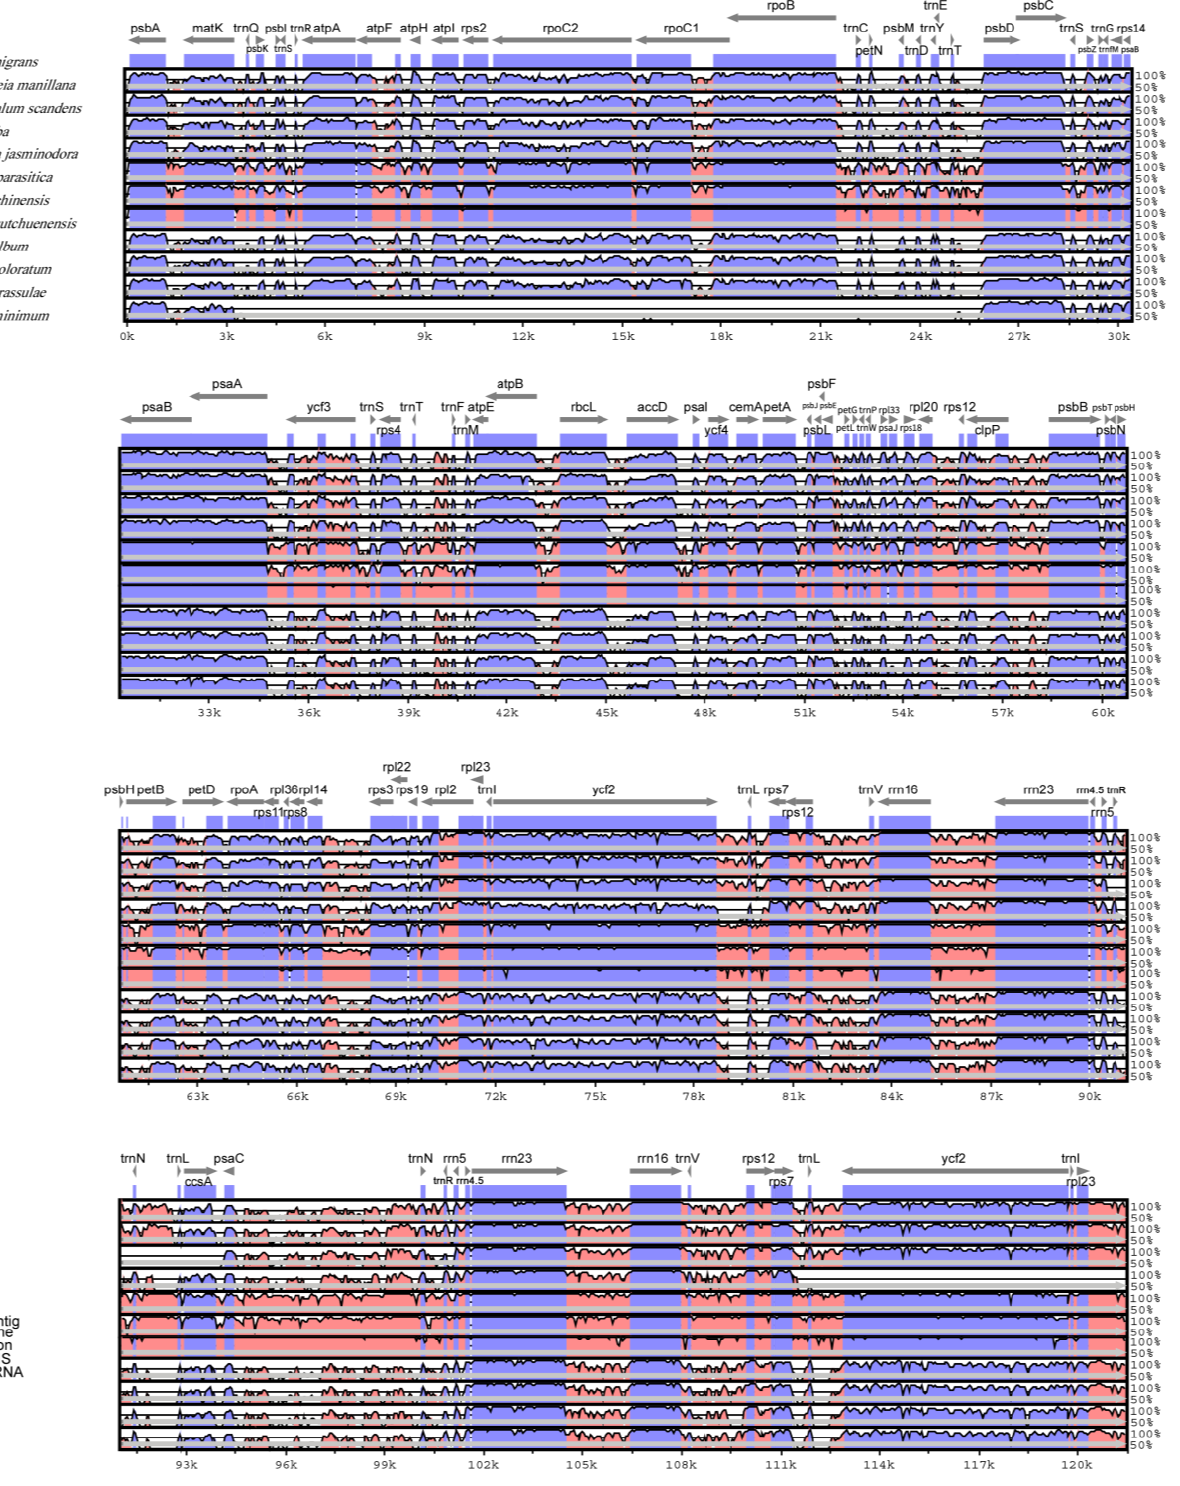
Figure 2. Comparison of the chloroplast genomes of the 12 species, using T. nigrans as a reference in the mVISTA program. (Grey arrows and thick black lines above the alignment indicate the orientation of genes. A cut-off of 70% identity was used for the plots. The Y-scale axis represents the percent identity within 50%–100%. Genomic regions are color-coded as either protein-coding exons, rRNAs, tRNAs, or conserved non-coding sequences (CNS), the same as below).